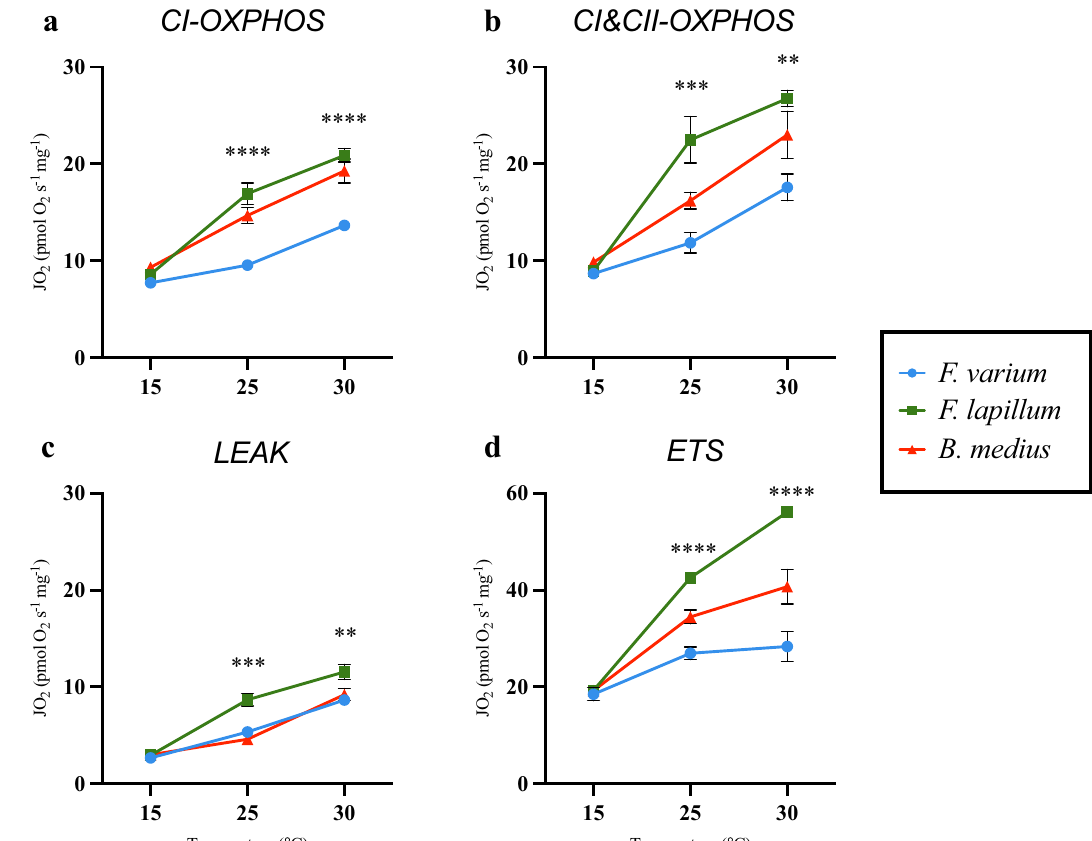
Figure 3. Respiratory flux in each respiration state of mitochondria at 15, 25, and 30 °C. Mean respiratory flux normalized to tissue wet weight (pmol O 2 s −1 mg −1 ) following the modified SUIT protocol for respiration and ATP determination. CI-OXP is initiated by the addition of PMG in the presence of ADP, CI&CII-OXP is initiated by the addition of S. CI&CII-Leak (denoted LEAK) is measured following the addition of the inhibitors Oligomycin (Oli) and carboxyatractyloside (cAtr) while rates of uncoupled respiration (denoted ETS) were measured after complete uncoupling with CCCP. ( a ) Mitochondrial flux during “CI-OXPHOS” for F. varium, F. lapillum and B. medius across the three experimental temperatures. ( b ) Mitochondrial flux during “CI&CII-OXPHOS” for F. varium, F. lapillum and B. medius across the three experimental temperatures. ( c ) Mitochondrial flux during “LEAK” for F. varium, F. lapillum and B. medius across the three experimental temperatures. ( d ) Mitochondrial flux during “ETS” for F. varium, F. lapillum and B. medius across the three experimental temperatures. Significant differences of p ≤ 0.05 between species within states are denoted by an asterisk (*), significant differences of p ≤ 0.01 are denoted (**), differences of p ≤ 0.001 are denoted (***) while differences of p ≤ 0.0001 are denoted